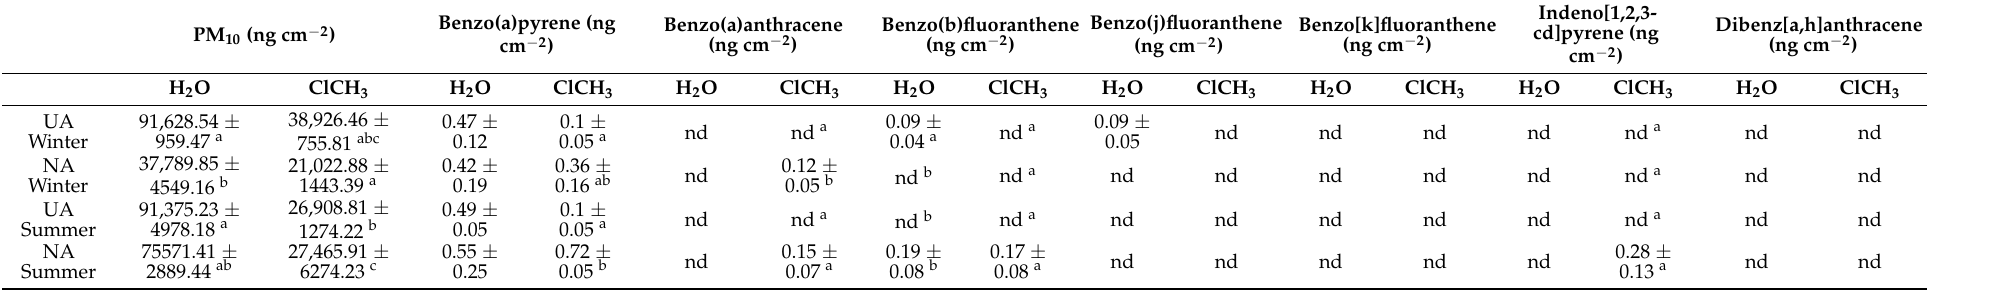
Symbols as: nd—not detected. Different letters indicate significant differences among samples (UA n = 9; NA n = 6; p <